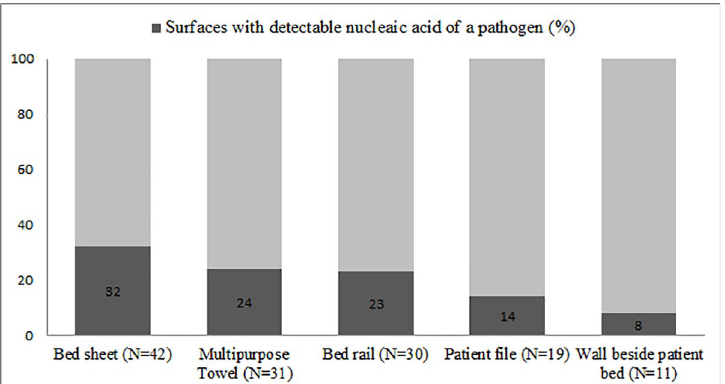
Fig 1. Percentage of different hospital surfaces � tested with detectable nucleic acid for common respiratory pathogens in two tertiary care hospitals in Bangladesh, September-November, 2013. � Surfaces collected nearby patients with at least one detectable pathogen in respiratory